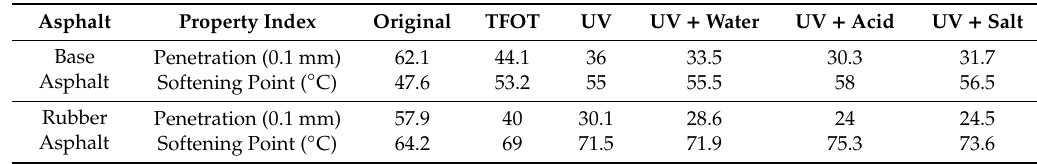
Table 4. Physical property indices of base asphalt and rubber